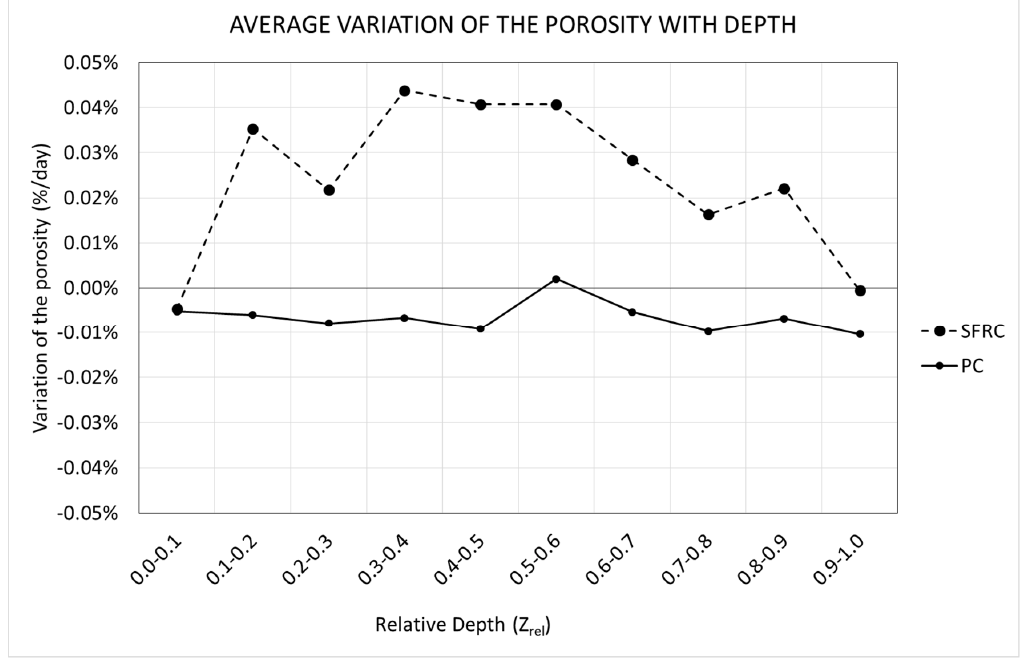
Figure 12. Variation of the porosity variation speed along the depth.